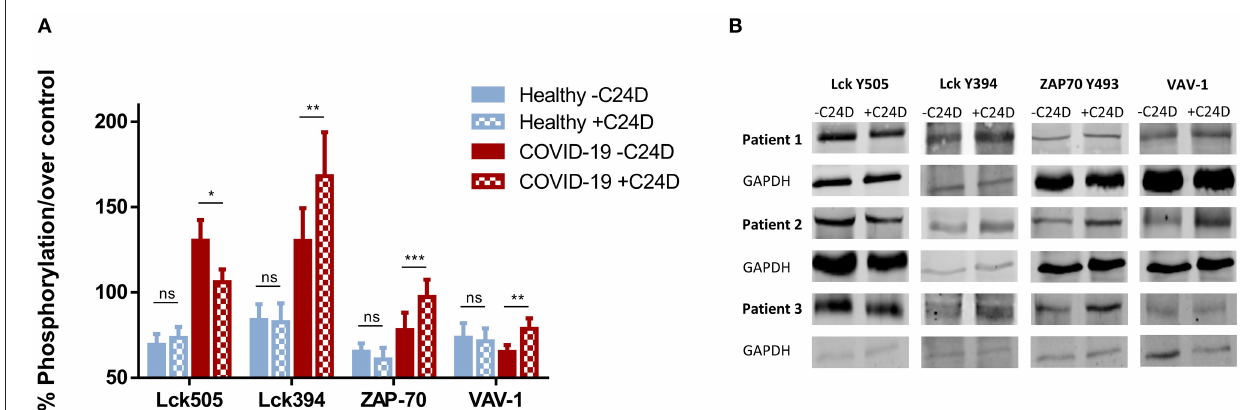
FIGURE 1 | C24D binding to CD45 triggers the CD45 signaling pathway: PBMCs from ten hospitalized patients, ± C24D treatment, were lysed, separated on 10% SDS and blotted with antibodies for the determination of phosphorylation of the tyrosine 505 and 394 in Lck, the tyrosine 493 in ZAP-70 and the tyrosine 174 in VAV-1. PBMCs from healthy volunteers served as controls. The percentage of phosphorylation was calculated individually vs. GAPDH as protein control. (A) Percentage change of protein phosphorylation in PBMCs from 10 patients, compared to 10 healthy donors, after addition of C24D for 5–60min to patient PBMCs, or 24h to PBMCs from healthy donor (values represent mean ± SE, * p < 0.01, ** p < 0.005, *** p < 0.0001). (B) Western blot results obtained in three representative patients for each phosphorylated protein, ± C24D.